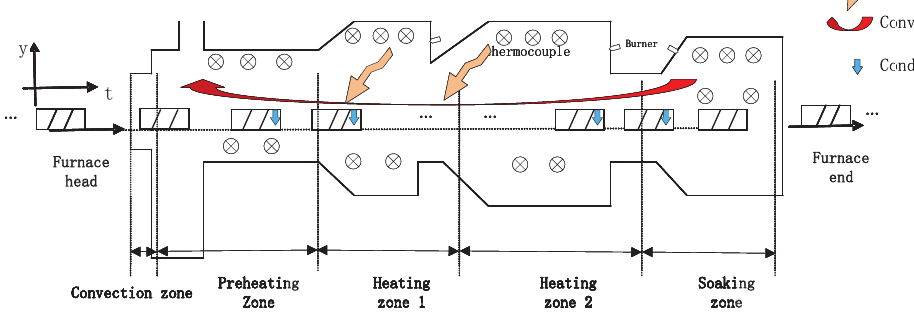
Figure 1. The structure of the reheating furnace.